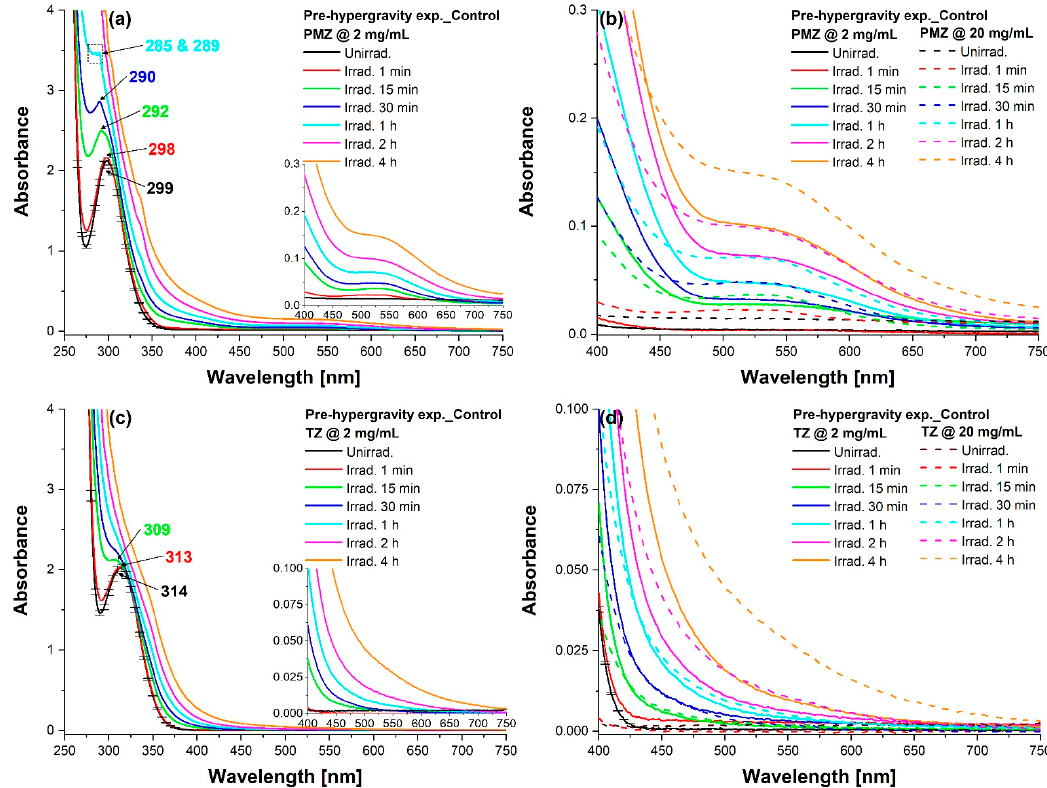
Figure 3. UV-Vis absorption spectra of uncentrifuged phenothiazine solutions recorded prior to the hypergravity treatment. ( a ) Unexposed and laser-exposed 2 mg/mL PMZ. ( b ) Comparison of 2 and 20 mg/mL PMZ. ( c ) Unirradiated and UV-irradiated 2 mg/mL TZ. ( d ) Comparison of 2 and 20 mg/mL TZ. Error bars: ±2.174%. At 2 mg/mL, unirradiated PMZ has an absorption band peaking at 299 nm and unir- radiated TZ at 314 nm, which can be attributed to n– π * electronic transition [35]. By ex- tending the UV exposure time interval, the respective peaks suffered hypso- and hyper- chromic shifts, an exponential decay characterizing the kinetics of the peak wavelength and a linear increase the kinetics of the absorbance intensity in the case of PMZ as well as TZ (Supplementary Figure S2). PMZ experienced a split of the absorption maximum into two peaks (285 and 289 nm) corresponding to the 1 h irradiated sample and a 9 nm hyp- sochromic shift during the first 30 min of laser exposure (Figure 3a). Within 475–625 nm, a new broader band emerged, featuring a slight hyperchromic effect throughout the 4 h irradiation (Figure 3a inset). In the same Vis spectral region, a similar behavior (new broadband formation and gradual intensity increase up to 4 h exposure) was noticed in the case of 20 mg/mL PMZ (Figure 3b). When laser exposure of 2 mg/mL TZ took place, a 5 nm hypsochromic shift of the absorption peak was detected by the end of the 15 min irradiation alongside a hyperchromic effect (Figure 3c). As for the 20 mg/mL concentra- tion, progressive hyperchromic shifts were observed as laser irradiation time increased (Figure 3d). On the other hand, the focus was on the effect of different gravitational conditions on the evolution of UV-Vis absorption spectra of the above-mentioned drug solutions,